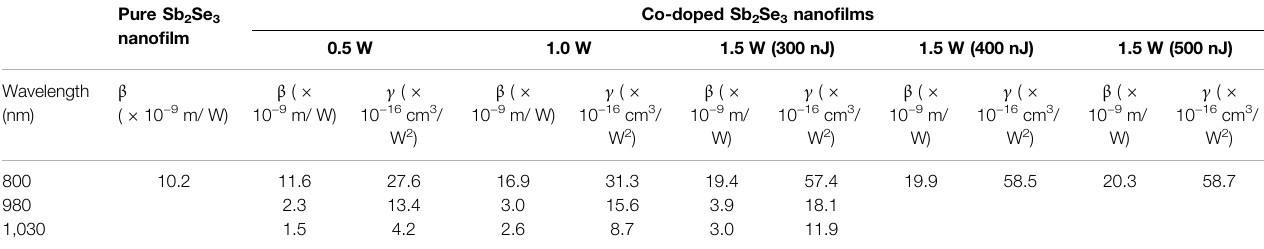
TABLE 1 | Nonlinear absorption parameters of the Co-doped and pure Sb 2 Se 3 nano fi lms under different excitation